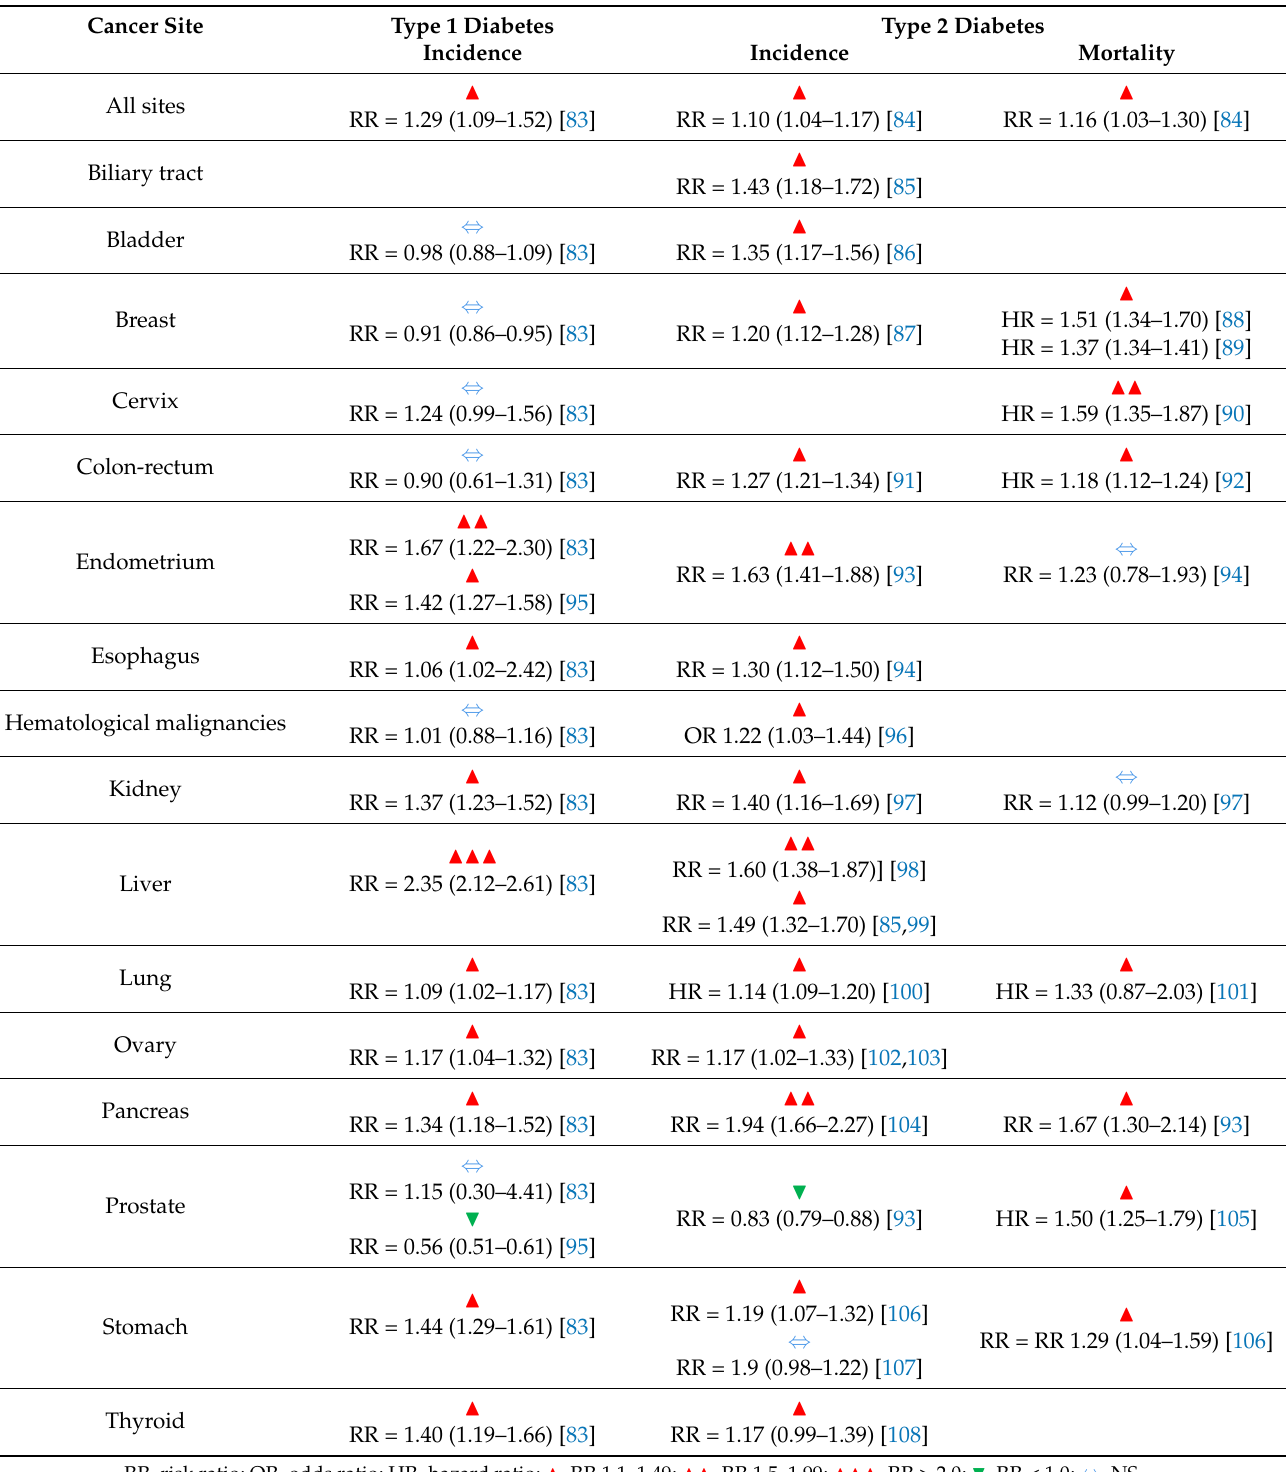
Table 1. Selected meta-analyses exploring the association between diabetes mellitus and cancer risk. Cancer